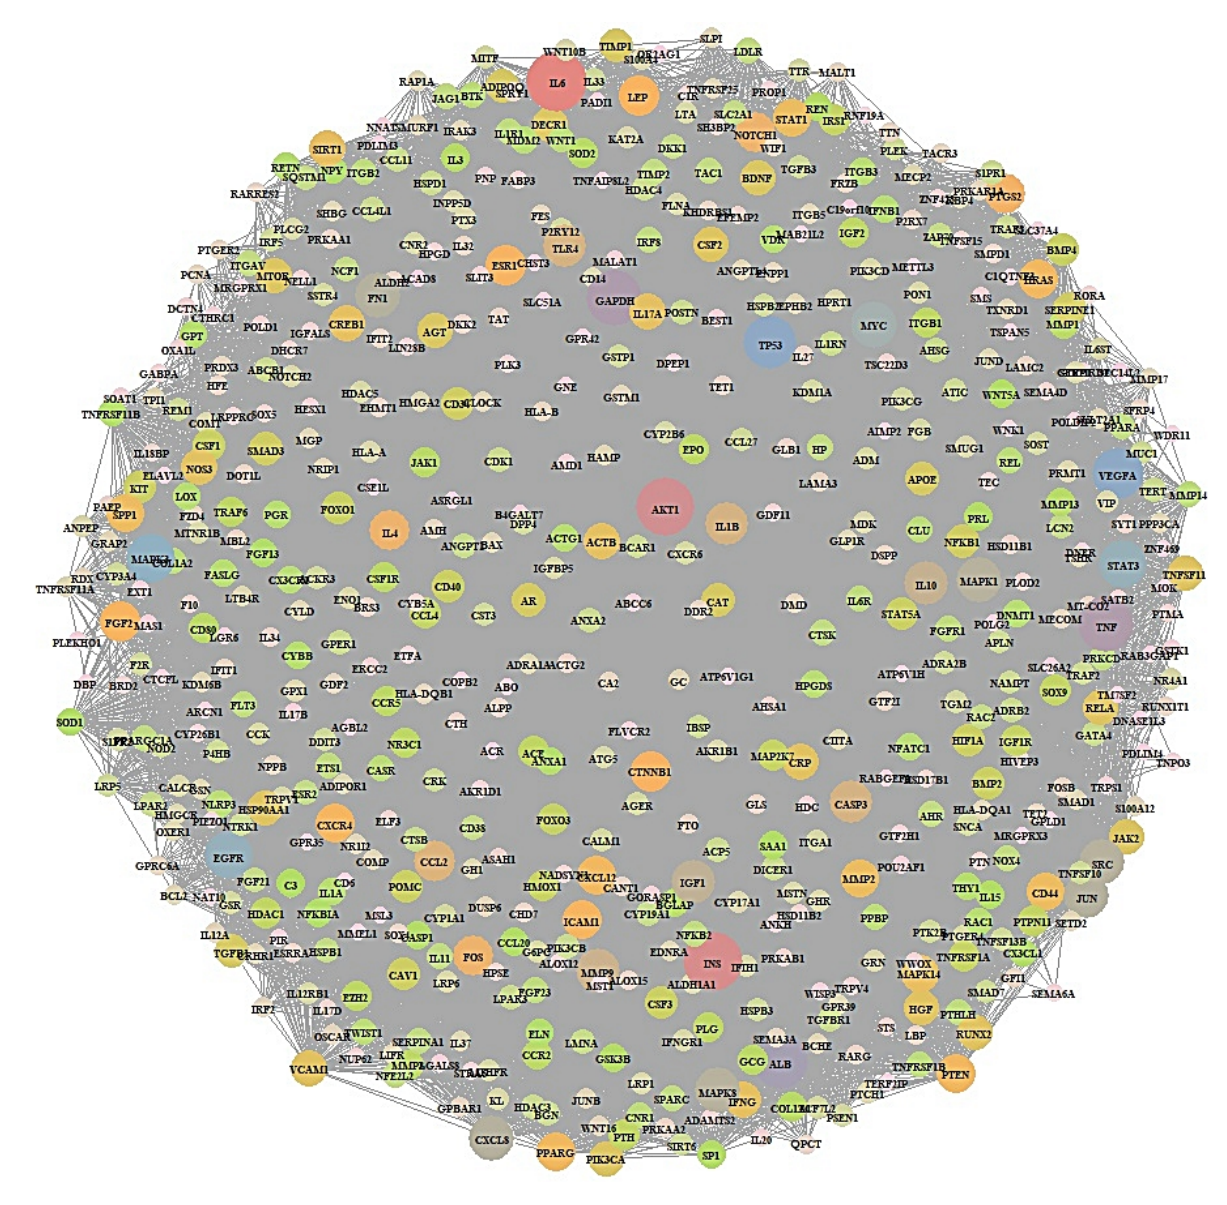
Figure 3. PPI network of 604 overlapping targets. Table 1. Degrees of value of the top 20 targets from PPI.